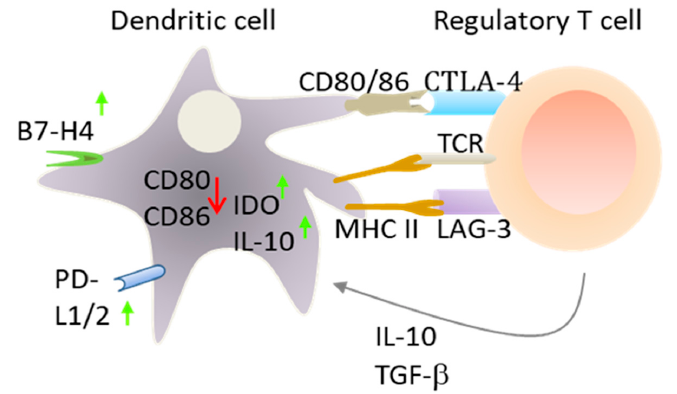
Figure 2. Induction of telerogenic DCs by Treg cells. A number of different factors/signals delivered by Treg cells might function in concert to convert immunogenic DCs into tolerogenic DCs. In addition to cell-cell interactions via membrane receptors, Treg cells can produce IL-10 and TGF- β , which inhibit the function of DCs and therefore the generation of effector T cells (see text). TCR: T cell receptor, LAG-3: lymphocyte activation gene 3, IL-10: interleukin 10.